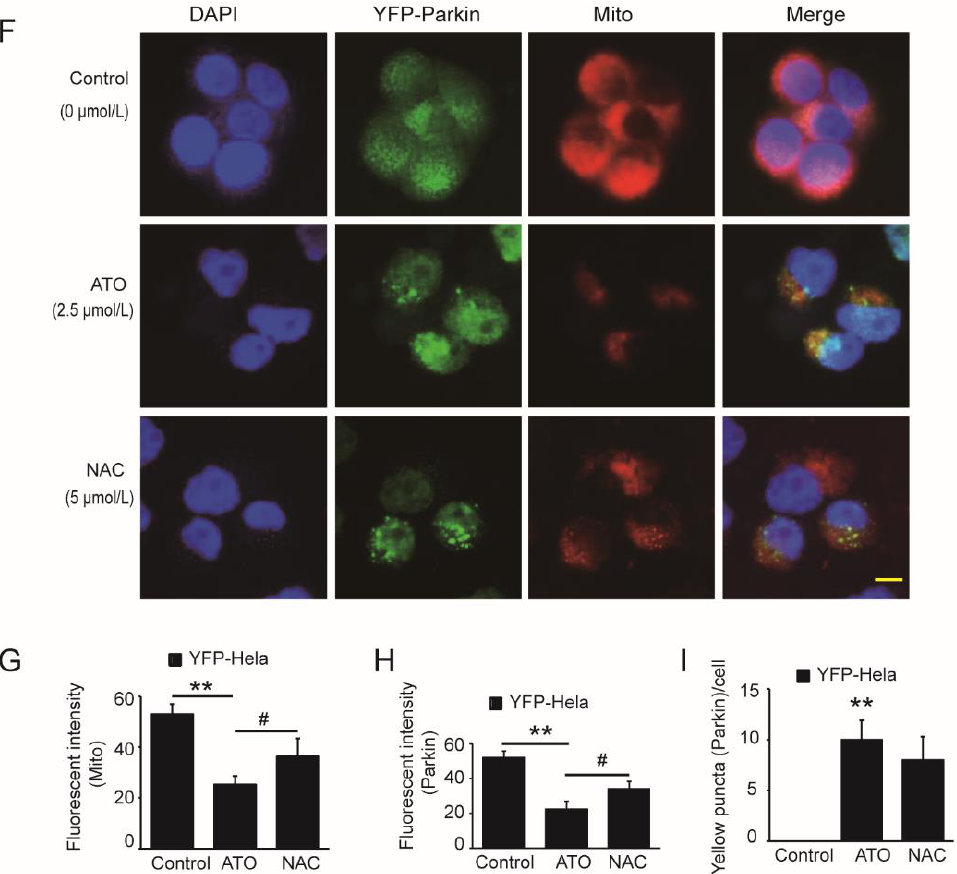
Figure 5. Potentiating effect of ATO on ROS production. ( A ) Red fluorescence indicates the production of ROS after cell treatment for 6 h, and the images were analyzed using a fluorescence microscopy. Scale bar, 10 µm. ( B ) shows the quantification of the red fluorescence, which was performed using Image J software. ( C ) YFP-Parkin HeLa cells were treated with the indicated concentrations of ATO for 24 h before detection of cell apoptosis by flow cytometry. ( D ) Western blot analysis of COX IV expression rescued after ATO treatment for 24 h in YFP-Parkin HeLa cells. ( E ) Quantification of D. ( F ) YFP-Parkin HeLa cells were fixed and immunostained for nuclei (blue) and mitochondria (red) after ATO treatment for 24 h. The red fluorescence indicated the normal mitochondrial membrane potential. The green fluorescence was the marker of YFP-Parkin proteins. The level of mitophagy was evaluated by the number of green puncta. The samples were analyzed using a fluorescence microscopy. Scale bar, 10 µ m. ( G ) Quantification of the red fluorescence, which was performed using Image J software. ( H ) Quantification of the green fluorescence, which was performed using Image J software. ( I ) Quantification of green puncta, which was performed using Image J software. The histograms represent the mean ± S.D. of triplicate experiments. * p < 0.05 vs. 0 µ mol/L group, ** p < 0.01 vs. 0 µ mol/L group, # p < 0.05 vs. without Parkin group. Without NAC group; GAPDH served as an internal